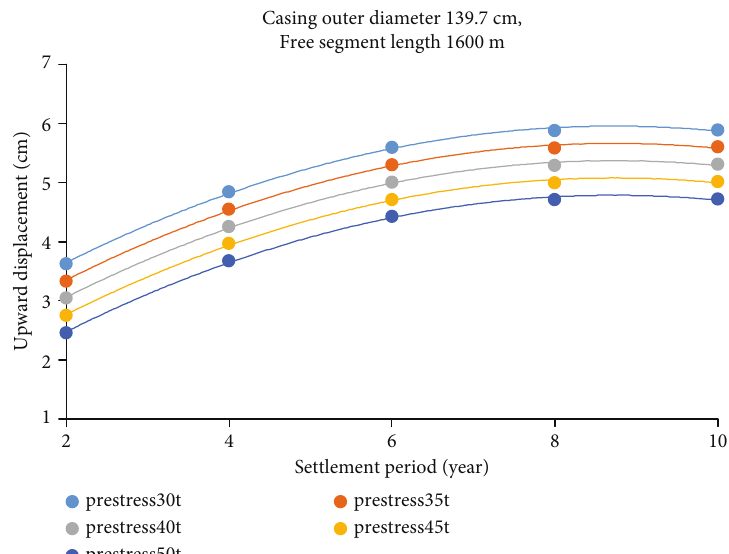
Figure 14: Relationship between the amount of moving up under di ff erent prestresses of three-open wells with time (casing outer diameter